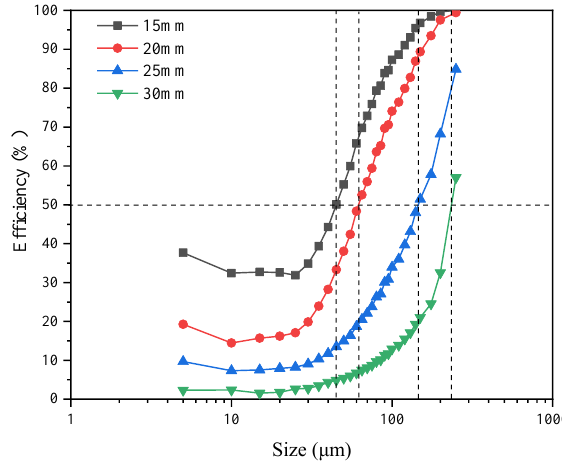
Figure 17. The classification efficiency curve.